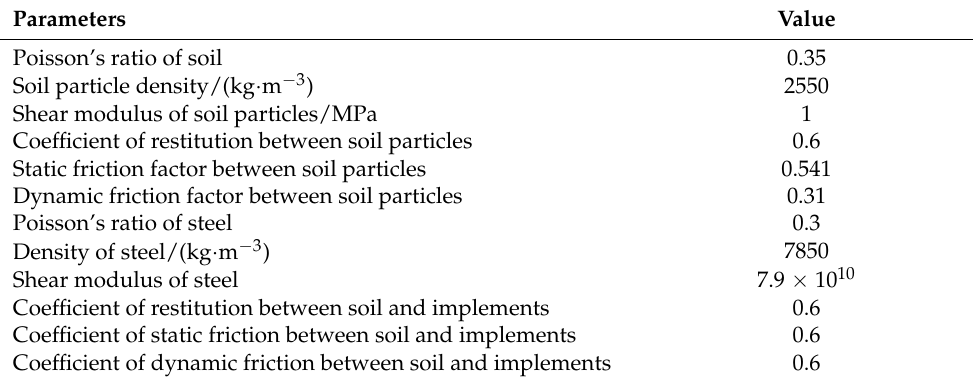
Table 3. Basic parameters of discrete element model.